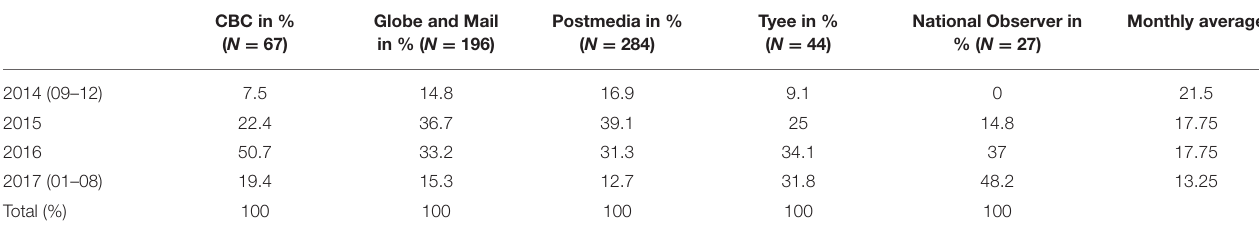
TABLE 3 | Yearly distribution of PNW news items.